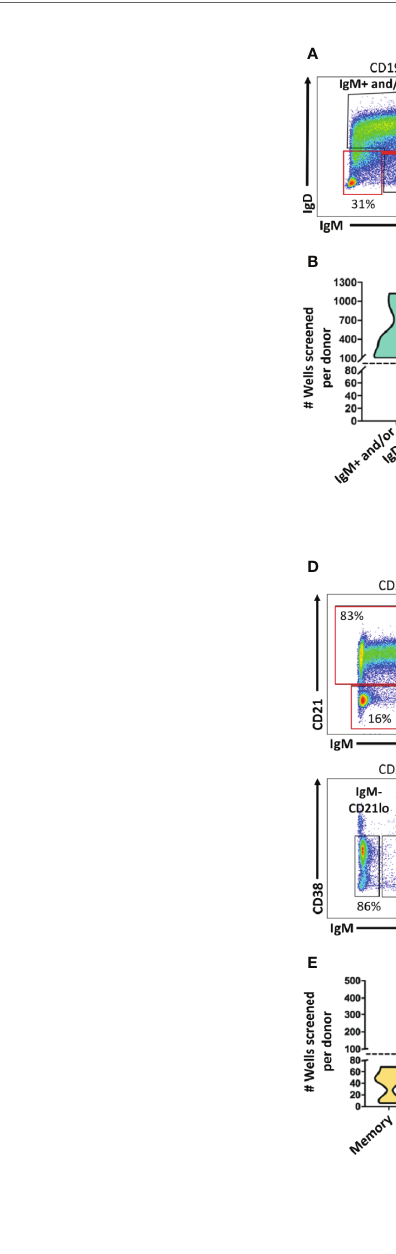
FIGURE 2 | Mature naïve, memory, and autoreactive-prone B cell subsets differentiate into antibody-secreting cells following in vitro stimulation. (A) Representative plots show fl ow cytometry identi fi cation of the indicated B cell subsets (gated on CD19 + live singlet lymphocytes). Subsets were de fi ned as follows: IgM + and/or IgD + , CD27 - memory (IgD + IgM + CD27 - CD38 - ), and CD27 + switched memory (IgD - IgM - CD27 + CD38 - ). (B) Violin plots show the data distribution and density for the number of all wells screened for each B cell subset per donor in (C), (C) PBMCs were isolated from systemic sclerosis/interstitial lung disease (black circle, n=6), systemic sclerosis (open circle/X, n=2), or ATD patients (open diamond, n=1) and B cell subsets were identi fi ed as in (A) and fl ow cytometry puri fi ed. Individual B cell subsets were plated in 384-well plates at ~300 B cells/well and stimulated as in Methods for 1 wk. ELISA was used to measure antibody present in culture supernatants. Wells were scored positively for antibody secretion for ELISA OD 370nm > 0.5. The frequency of positive wells was calculated per subset, per donor; individual points represent individual donors. (D) Representative plots show fl ow cytometry identi fi cation of the indicated B cell subsets (gated on CD19 + live singlet lymphocytes). Subsets were de fi ned as follows: memory (IgM - /IgD - or IgM mid/high CD21 + CD27 + CD38 - ), B ND (IgM low/neg /IgD + CD21 + ), IgM - CD21 lo (IgM - CD27 + CD38 mid/neg ), or IgM + CD21 lo (IgM + CD21 lo CD38 mid/neg ). (E) Violin plots show the data distribution and density for the number of all wells screened for each B cell subset per donor in (F), (F) PBMCs were isolated from systemic sclerosis/interstitial lung disease (black circle, n=5), Sjögren ’ s syndrome ( fi lled triangle, n=2), or ATD patients (open diamond, n=1) and B cell subsets were identi fi ed as in (D) and fl ow cytometry puri fi ed. Individual B cell subsets were plated in 384-well plates at ~ 300 B cells/well and stimulated as in Methods for 1 wk. Wells were scored positively for antibody secretion for ELISA OD 370nm > 0.5. The frequency of positive wells was calculated per subset, per donor; individual points represent individual